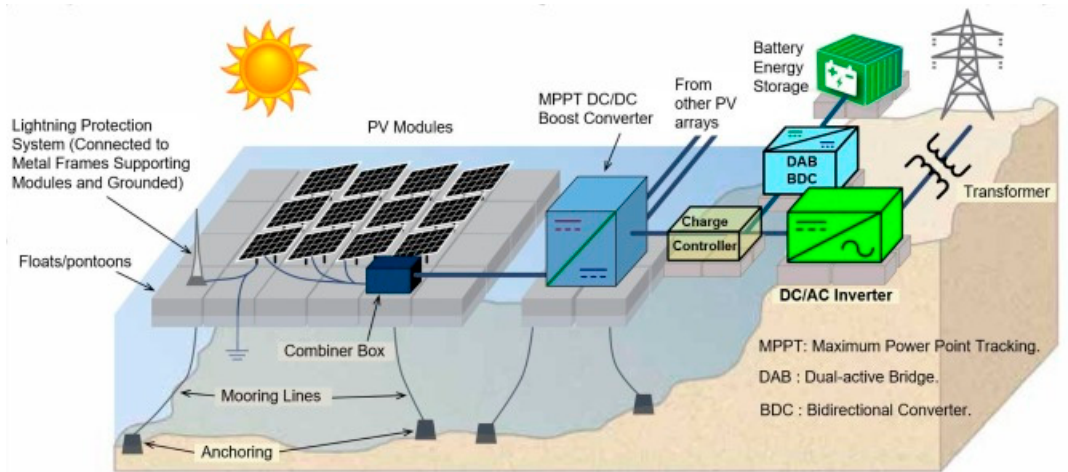
Figure 10. Architectural representation of FPV system. Reprinted/adapted with permission from Ref. [60]. 2022, Elsevier. Ref. [60]. 2022,